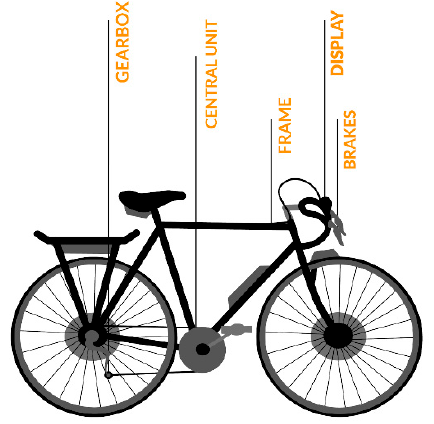
Inventions 2021 , 6 , 22 Figure 4. Architecture of the product of an electric bike. Figure 4. Architecture of the product of an electric bike.